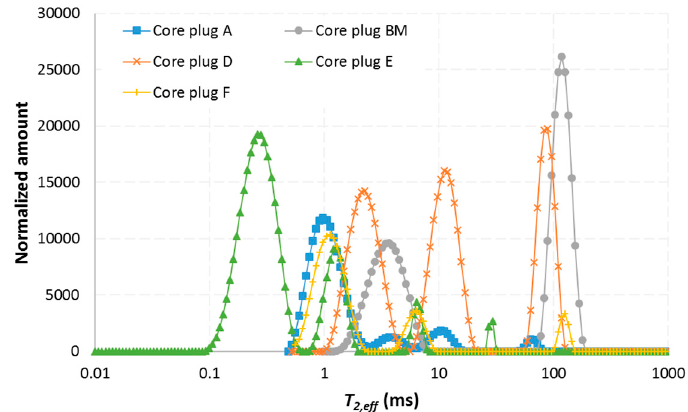
Figure 6. Transverse relaxation distribution for each core plug obtained by the CPMG sequence at high-field strength, B 0 = 4.70 T. Each distribution is normalized with respect to the bulk volume of the respective core plug. Table 2. Porosity of each core plug estimated by weight calculations and transverse relaxation distributions at low magnetic field strength.